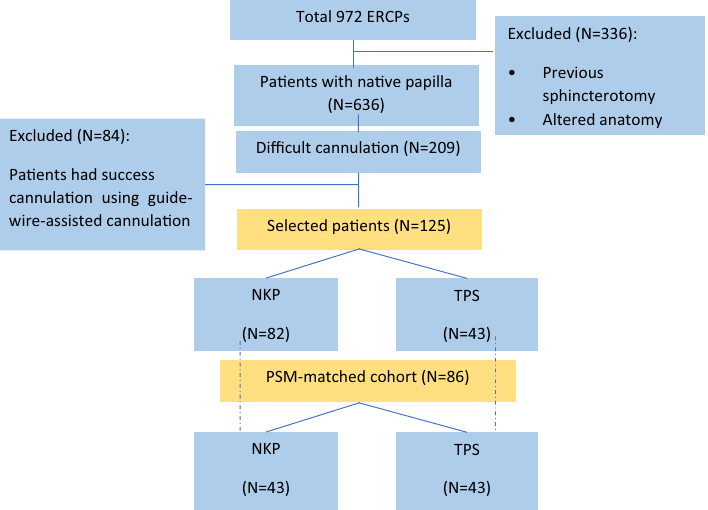
Figure 1. Study design and sample breakdown based on used difficult cannulation techniques before and after propensity score matching